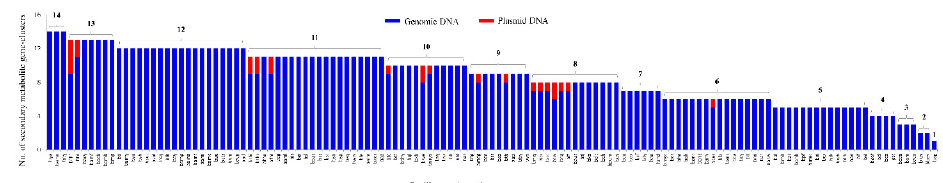
Figure 6. Comparative analysis of secondary metabolite BGCs in 128 Bacillus species (gDNA and plasmid DNA). Numbers next to bars indicate the number of secondary metabolite BGCs. Detailed analysis of secondary metabolite BGCs in each species is presented in Table S3.